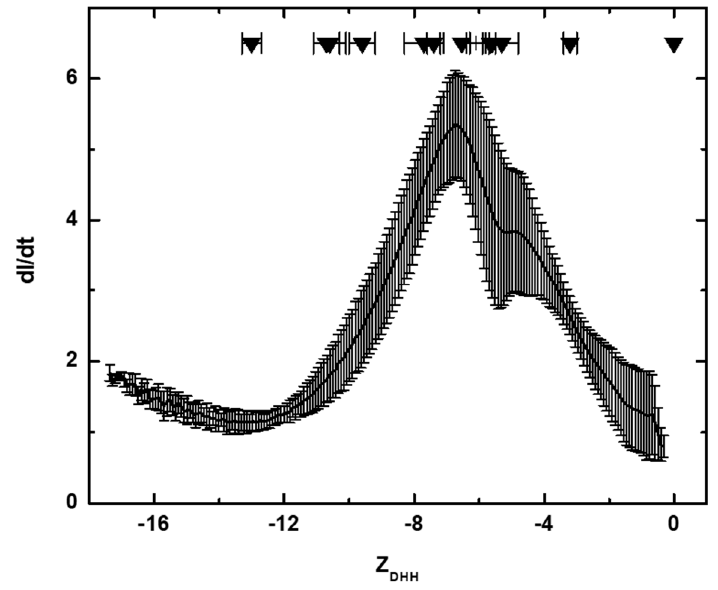
Figure 9. Z DHH distribution for freshly prepared human IgG in DPBS. Z DHH was calculated for T = 20 °C, viscosity = 0.98 cp, electric field = − 14.88 V/cm, ionic strength = 0.167 M, conductivity = 16.6 ms, protein radius = 5.5 nm, counterion radius = 0.18 nm, D = 78. The Z DHH for the twelve intact IgGs in this study are noted (inverted triangles) along with bars indicating the measurement uncertainty.